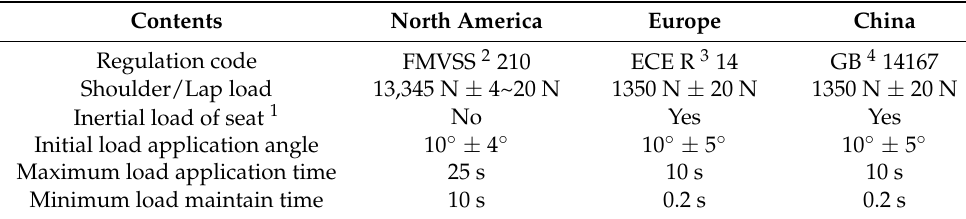
Figure 1. Configuration of seat belt anchorage test. Table 1. Load application of seat belt anchorage test in national regulation [11–13].